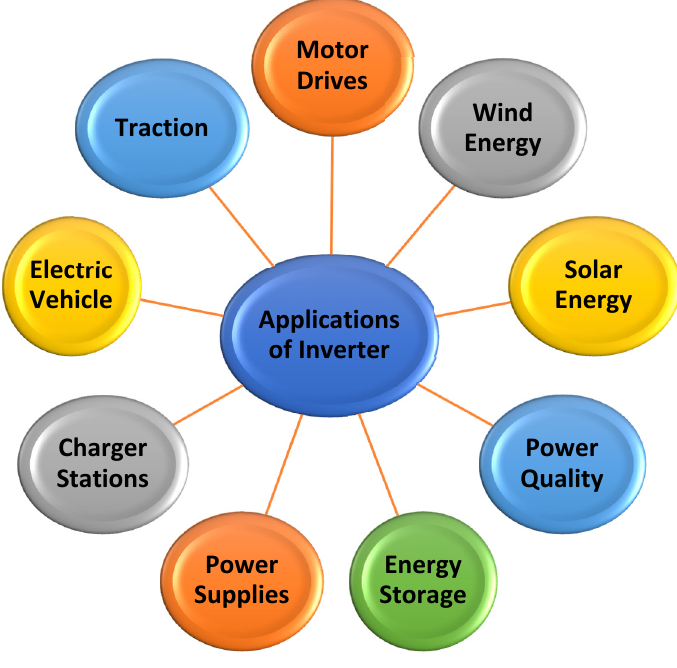
Figure 1. Inverter applications.